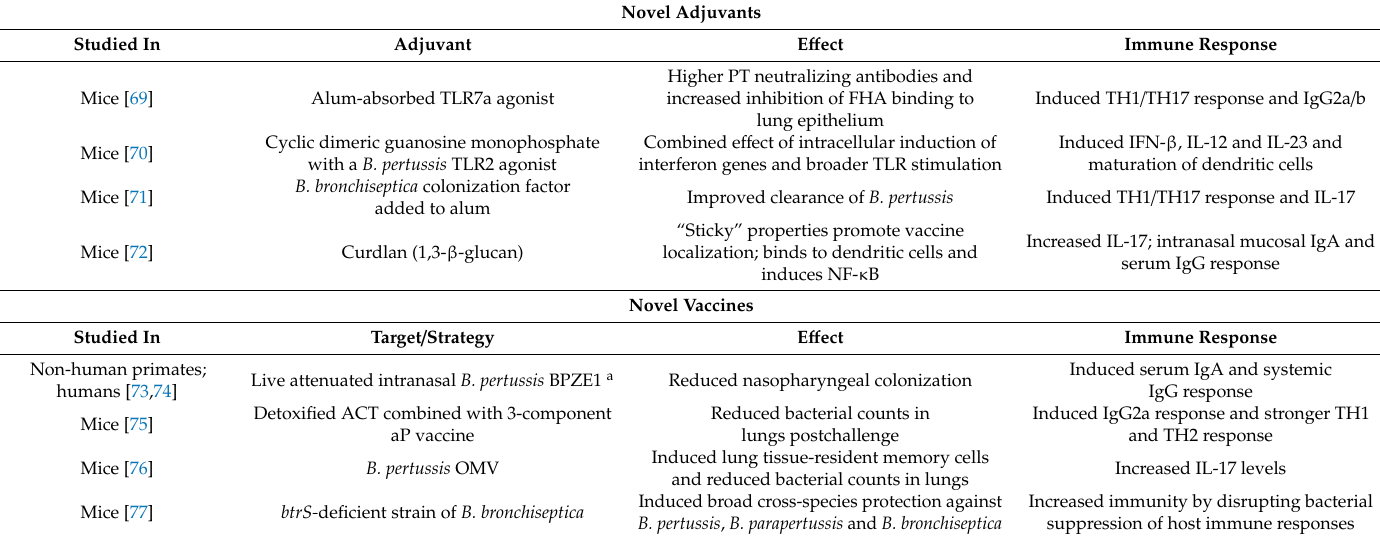
Table 2. Novel adjuvants and vaccines for Bordetella Pertussis